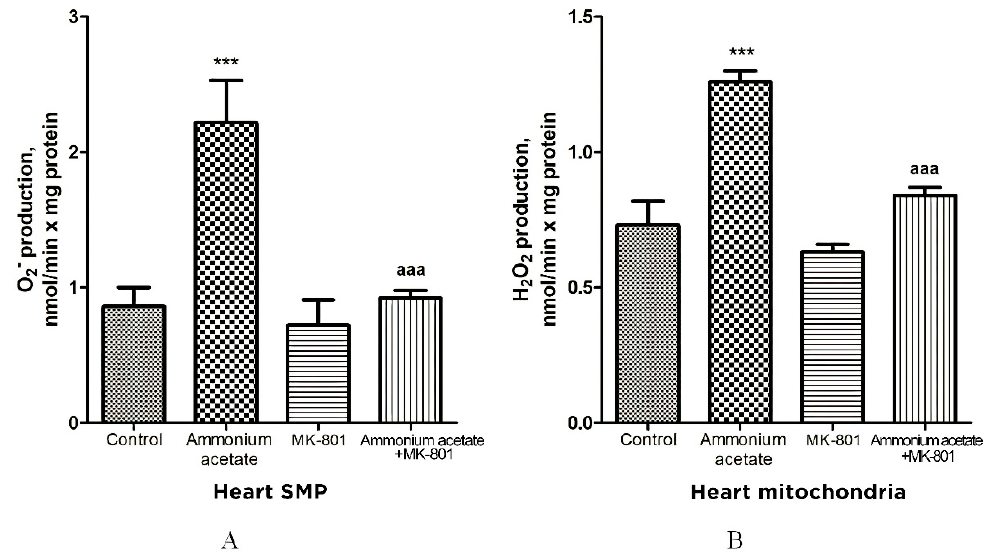
Figure 9. The effect of ammonium acetate and MK-801 injection on the rate of O 2 •− ( A ) and H 2 O 2 ( B ) formation in rat heart SMPs and mitochondria. Experimental design was the same as in Figure 1 legend. The rates of O2 •− and H 2 O 2 formation were determined as indicated in Materials and Methods. The results are represented as mean ± SEM. Values significantly different from the control group are designated with three (***) asterisks: *** p < 0.001 (Student’s t -test). a significant differences, compared with ammonia group. aaa p < 0.001 (with the Bonferroni correction for multiple comparisons).